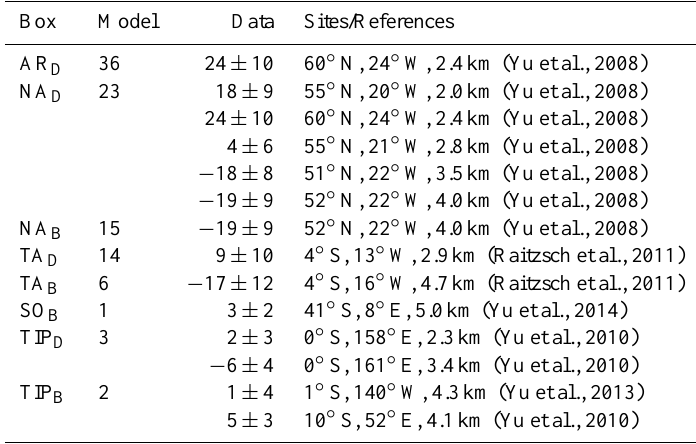
− concentrations (in µmolkg − 1 ): differences between 21 and 5ka calculated in the standard simulation STD are Table C1. Deep-sea CO 2 3 compared to corresponding observational data (derived from B / Ca ratios in foraminifera, LGM–Holocene differences).